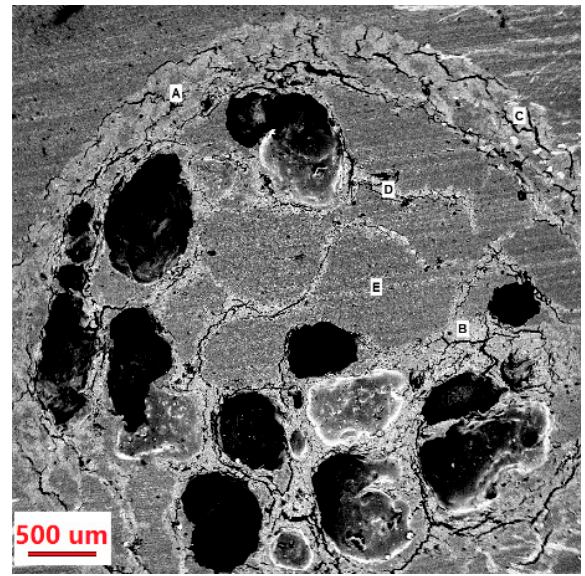
Figure 2. Scanning electron micrographs of cross-section MCCBs. A, B and C are cellulose; D and E are CF.